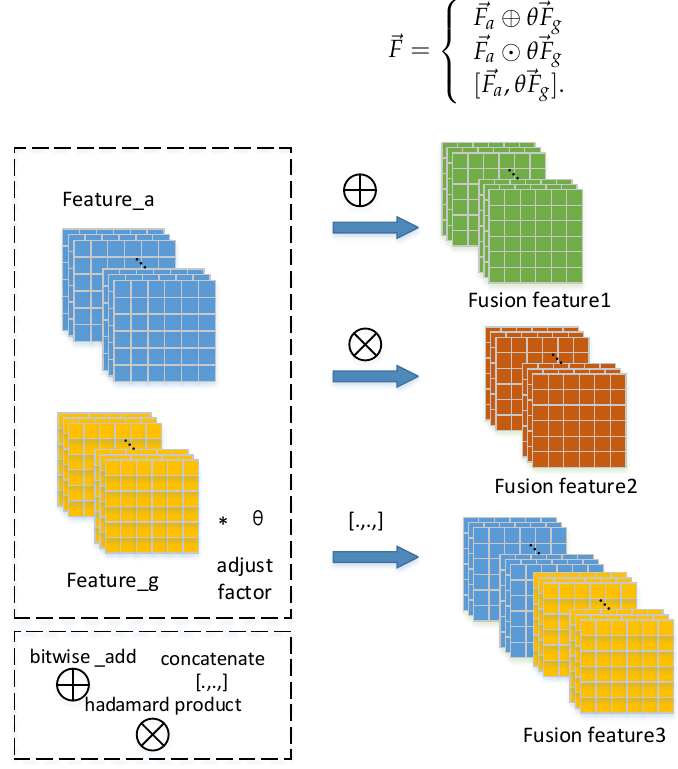
Figure 4. The three feature-level fusion modes between appearance and gait features. The sign ∗ denotes multiplication